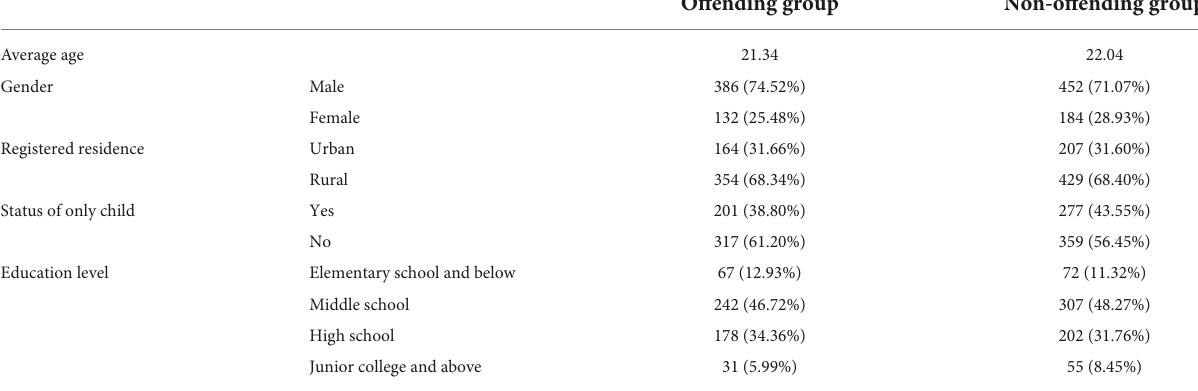
TABLE 1 Sample compositions between offending or non-offending groups ( n =